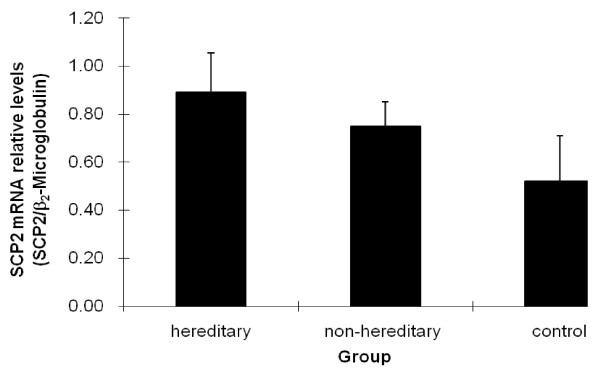
The mRNA levels of SCP2 in hereditary gallstone group, non-hereditary gallstone group and control group. SCP2 mRNA expression was assessed by semi quantitative RT-PCR and shown as fold change after normalized to β2-Microglobulin levels. SCP2 mRNA was expressed at higher levels in hereditary cholesterol gallstone patients than in non-hereditary cholesterol gallstone patients, P < 0.05. The mRNA expression of SCP2 in hereditary, and non-hereditary cholesterol gallstone patients were 0.8908 ± 0.1649, 0.7503 ± 0.1004 respectively, which were both higher than that in control group,0.5205 ± 0.1900, P < 0.05. The data was analyzed by one way analysis of variance, and F = 11.089, P < 0.05.